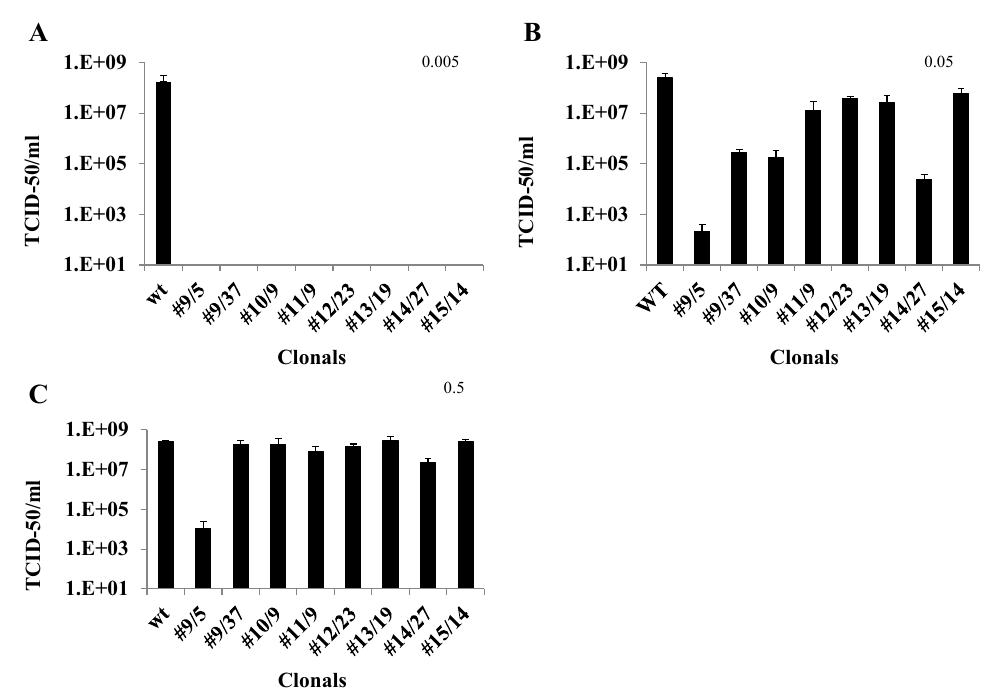
Figure 4. TCID 50 -IFA analysis of transformed Vero cell clones challenged with three different multiplicity of infections (MOIs) of CHIKV. ( A ) Challenge MOI of 0.005, and stained with anti-CHIKV antibody at 3 dpi; ( B ) Challenge MOI of 0.05, analyzed at 2 dpi. ( C ) Challenge MOI of 0.5, analyzed at 2 dpi. Each bar represents an average CHIKV titer obtained from three independent infections. Statistically significant differences were determined relative to the infected control sample (wt) using one-way ANOVA (GraphPad prism 6.0 software, Dunnett’s, p < 0.01). Error bars show the standard deviation among the three replicates for each clone. Individual clones are designated as hRz number/clone number.